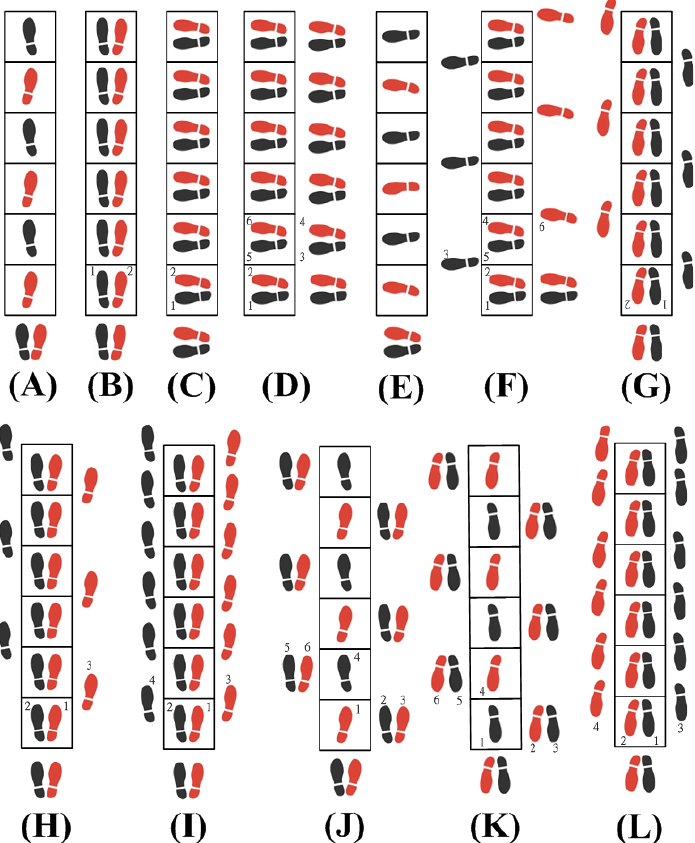
Figure 1. The schematic representation of the agility ladder exercises. ( A ) Frontal one in, one out, ( B ) Two in the hole, ( C ) Two in lateral, ( D ) Lateral two in, two out, ( E ) One lateral, ( F ) Lateral ickey shuffle, ( G ) Ickey shuffle backward, ( H ) Ickey shuffle, ( I ) Frontal two in, two out forward, ( J ) Zig-zag crossover shuffle, ( K ) Zig-zag crossover shuffle backward, ( L ) Frontal two in, two out backward. Table 1. The agility ladder exercises performed during the intervention program. Rest intervals be- tween repetitions lasted 30 s. Rest intervals between sets lasted 60 s.